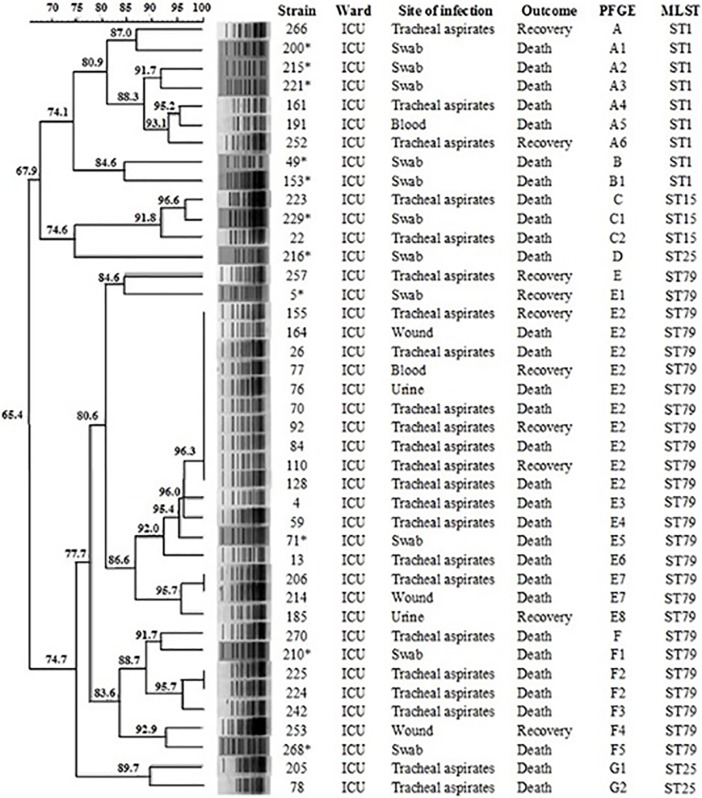
Dendrogram displaying the genetic relatedness of 41 OXA-23-producing A. baumannii strains recovered in a Brazilian ICU, based on PFGE data and MLST content.Asterisks indicate the colonizing strains.